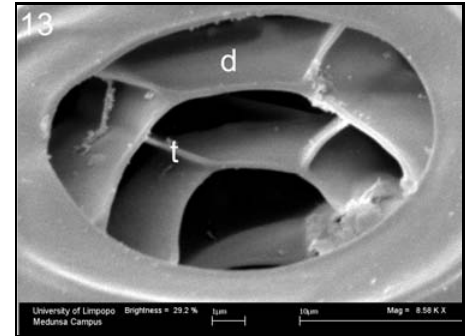
Fig. 12. The thoracic spriracle